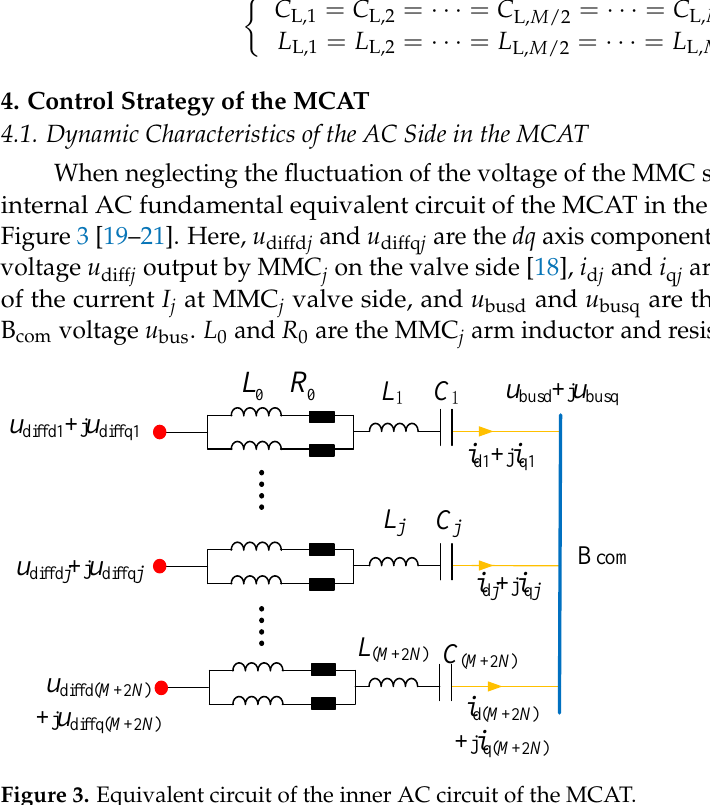
Figure 3. Equivalent circuit of the inner AC circuit of the MCAT.